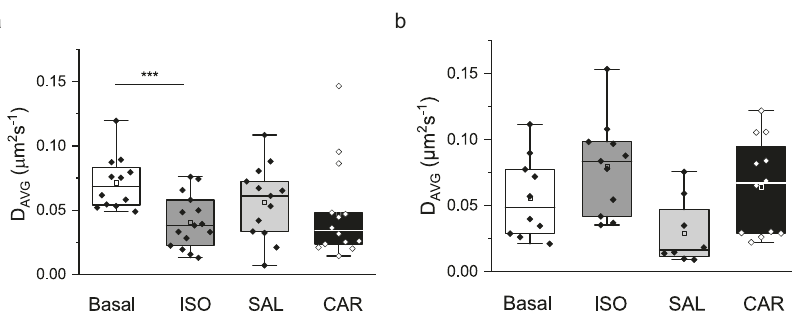
Fig. 5 Ligand stimulation affects diffusion constants. a Ligand effects on membrane diffusion of NT expressed in CHO-K1 cells. The cells were incubated for 5 min with each of the ligands (ISO and CAR at 1 µ M and SAL at 2.4 µ M) prior to measurement. Average diffusion constants, D AVG , weighted over the corresponding species fractions (Eq. (5)), are shown: Basal untreated state (white) 0.07 ± 0.04 µ m 2 s − 1 , ISO (dark gray) 0.04 ± 0.02 µ m 2 s − 1 , SAL (light gray) 0.06 ± 0.03 µ m 2 s − 1 and CAR (black) 0.05 ± 0.04 µ m 2 s − 1 . *** is P < 0.001. b Ligand effects on membrane diffusion of S expressed in CHO-K1 cells. The incubation was the same as NT. Average diffusion constants, D AVG for the basal and ligand treated states are shown: Basal untreated